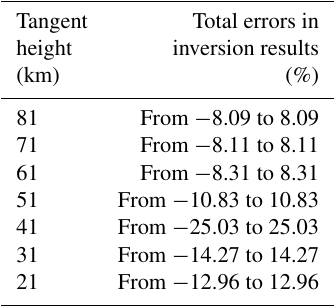
Table 8. Total errors in inversion results at some tangent heights.